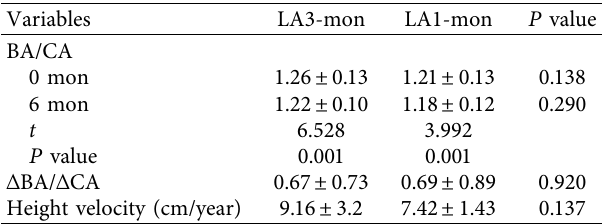
Table 4: Changes of bone age and height velocity in girls after treatments with